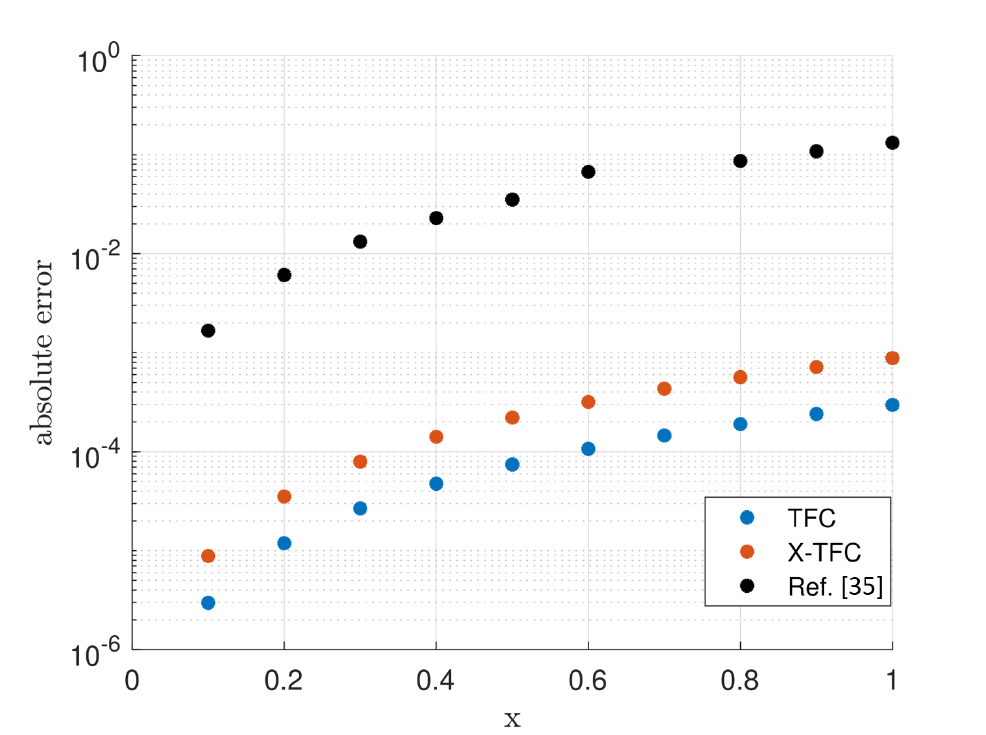
Figure 2. Absolute error on test points for problem